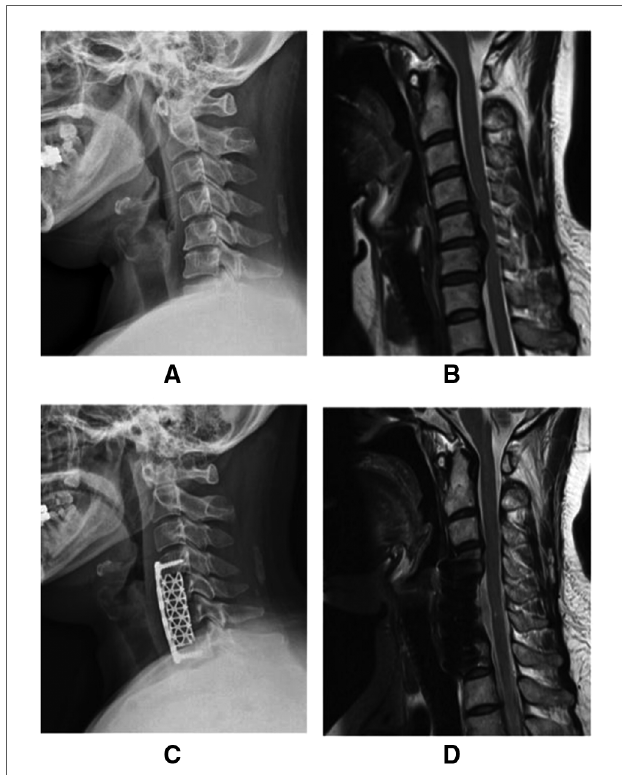
FIGURE 2 Anterior cervical subtotal corpectomy with titanium plate and screw fi xation. ( A ) Lateral radiograph showing cervical kyphosis. ( B ) Posterior compressing of the spinal cord at the C4/5 – C6/7 level. ( C ) Postoperative improved cervical alignment. ( D ) Postoperative MRI showing the decompressed spinal cord.